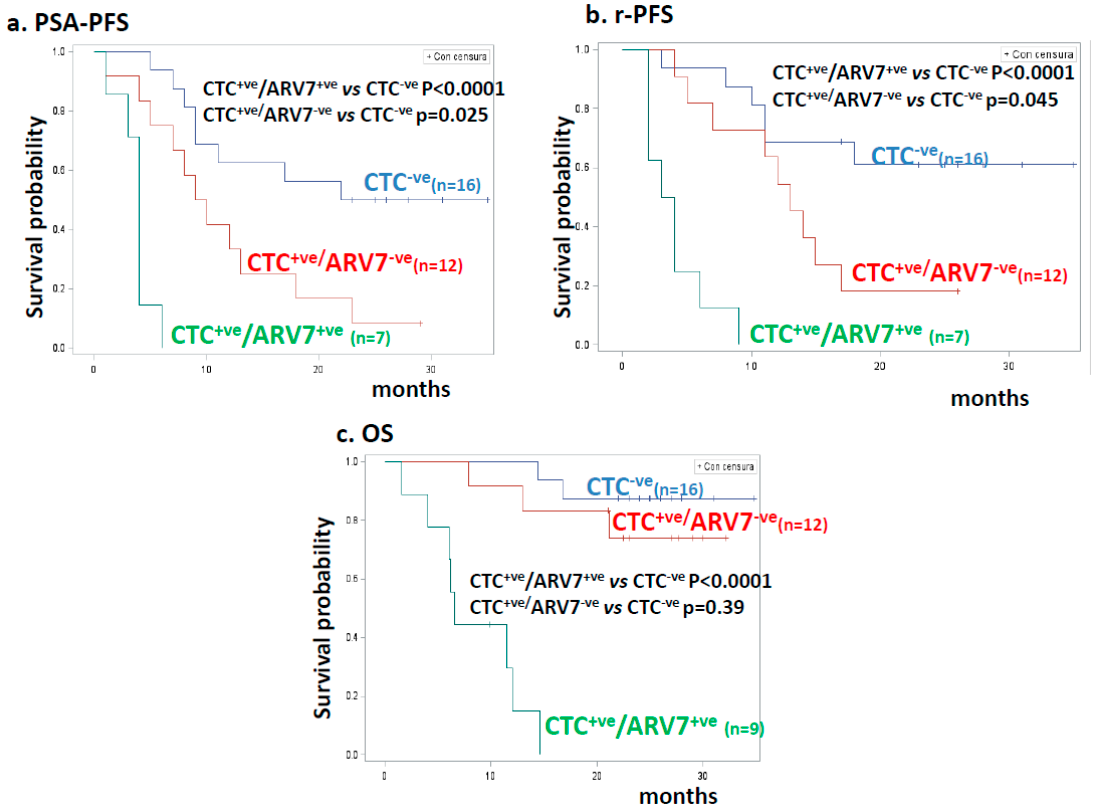
Figure 4. Kaplan–Meier estimates for clinical outcome in patients stratified by CTC and ARV7 detection. ( a ) PSA-progression-free survival (PSA-PFS) according to ARV7 detection. Blue, red, and green lines indicate 16 CTC-negative (CTC − ve ), 12 CTC-positive / ARV7-negative (CTC + ve / ARV7 − ve ), and seven CTC-positive / ARV7-positive (CTC + ve / ARV7 + ve ) patients, respectively. HR values, 95% confidence interval (CI), number of patients, and statistical significance are reported in the inset. ( b ) Radiologic progression-free survival (rPFS) according to AR status. Blue, red, and green lines indicate 16 CTC-negative (CTC − ve ), 12 CTC-positive / ARV7-negative (CTC + ve / ARV7 − ve ), and seven CTC-positive / ARV7-positive (CTC + ve / ARV7 + ve ) patients, respectively. HR values, 95% confidence interval (CI), number of patients, and statistical significance are reported in the inset. ( c ) Overall survival (OS) according to ARV7 status. Blue, red, and green lines indicate 16 CTC-negative (CTC − ve ), 12 CTC-positive / ARV7-negative (CTC + ve / ARV7 − ve ), and nine CTC-positive / ARV7-positive (CTC + ve / ARV7 + ve ) patients, respectively. HR values, 95% confidence interval (CI), number of patients, and statistical significance are reported in the inset.